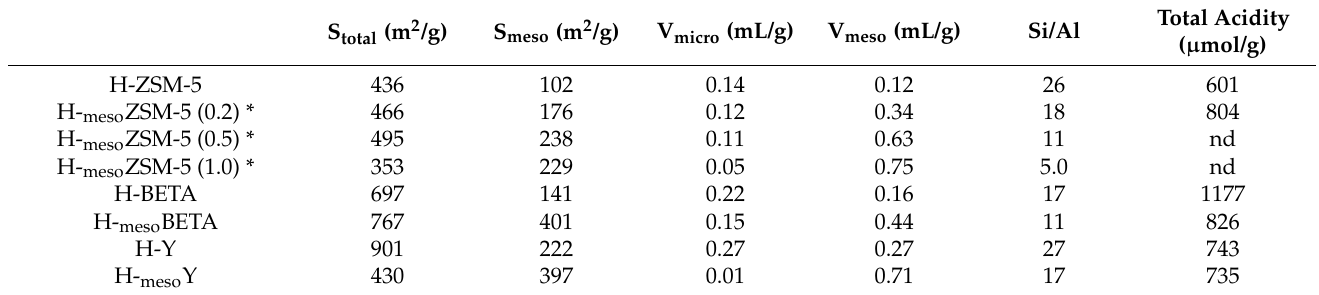
Table 1. Summary of zeolite properties used for the Co catalyst preparation.